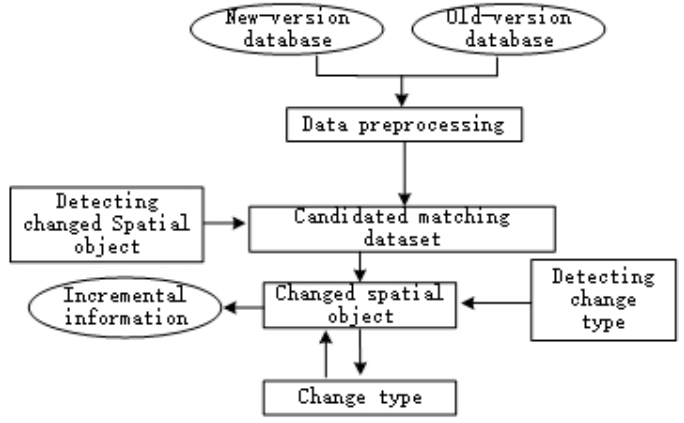
Figure 1. The incremental information extraction process.